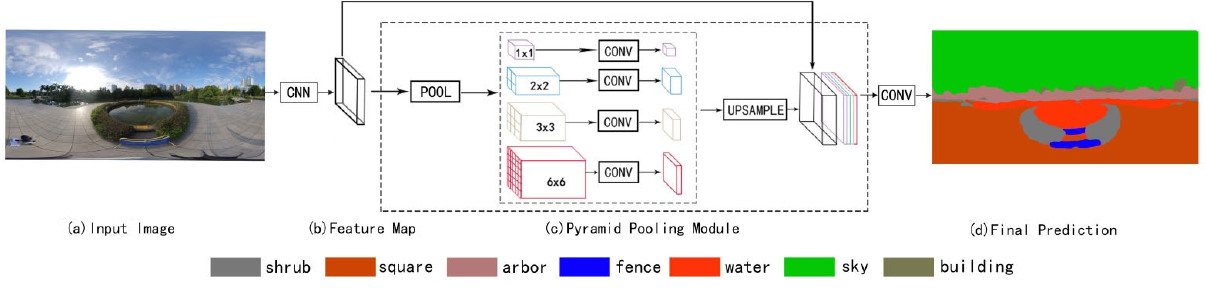
Figure 2. PSP ‐ Net model